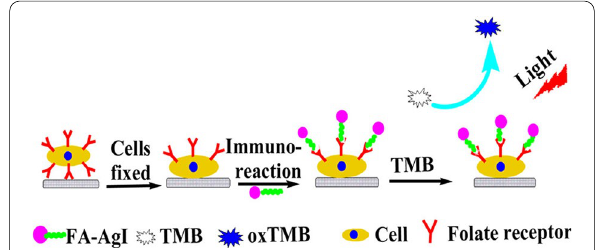
Fig. 5 Proposed detection process using FA-CS-AgI. Adapted from Ref. [115] with permission. Copyright (2014) ACS Publications